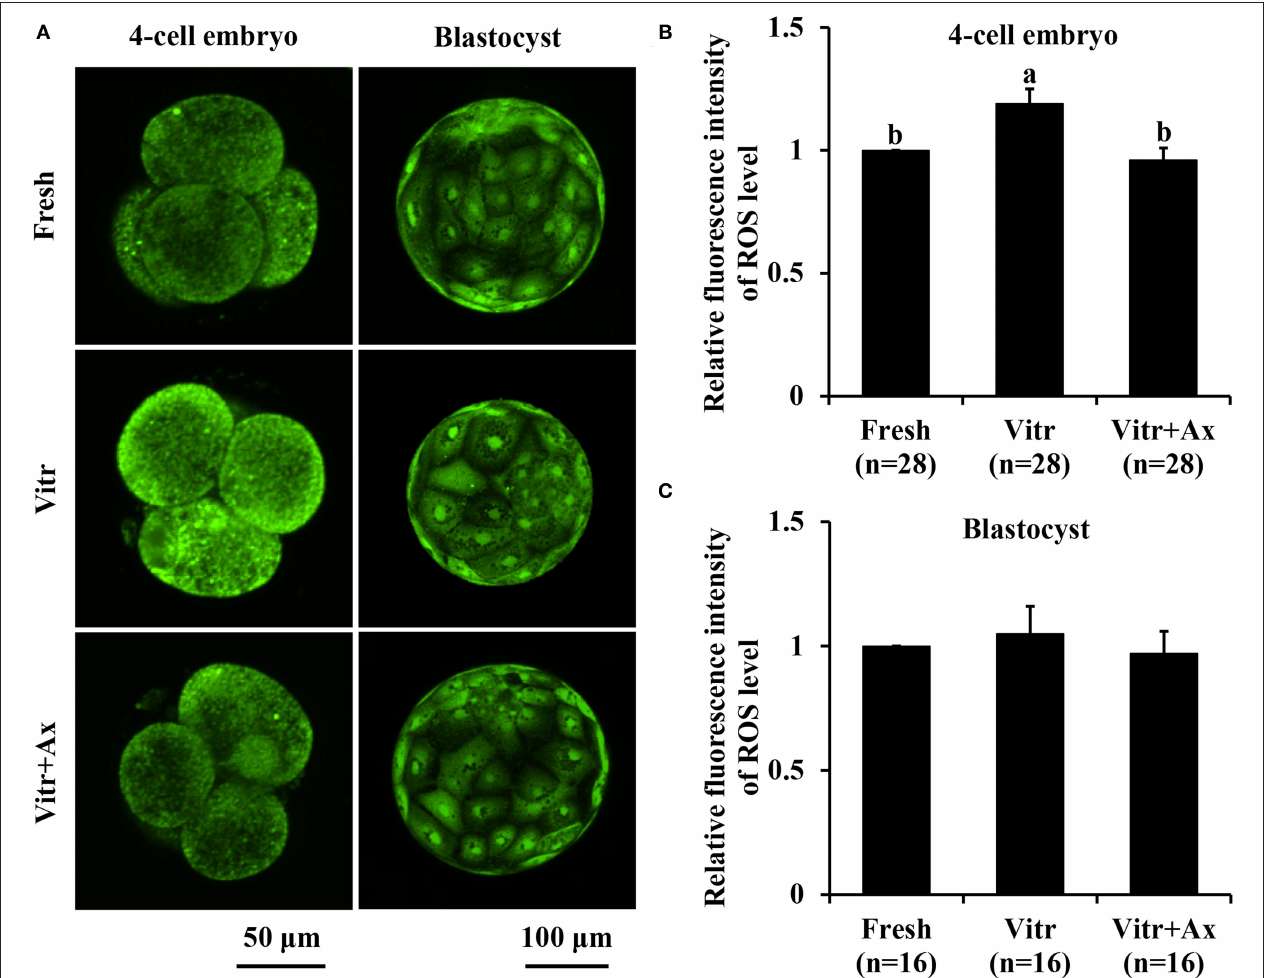
FIGURE 2 | Effects of astaxanthin (Ax) supplementation on intracellular reactive oxygen species (ROS) level in resultant 4-cell embryos and blastocysts. (A) Representative images of ROS signals stained with CM-H 2 DCFDA. (B,C) Graphical representation of ROS level by quantifying the relative fluorescence intensity. Four replications were performed. Data are the mean ± SEM values. Different superscripts above columns indicate significant differences ( P < 0.05). The three experimental groups: fresh zygotes (Fresh group), vitrified zygotes (Vitr group), and vitrified zygotes cultured with Ax (Vitr + Ax group).